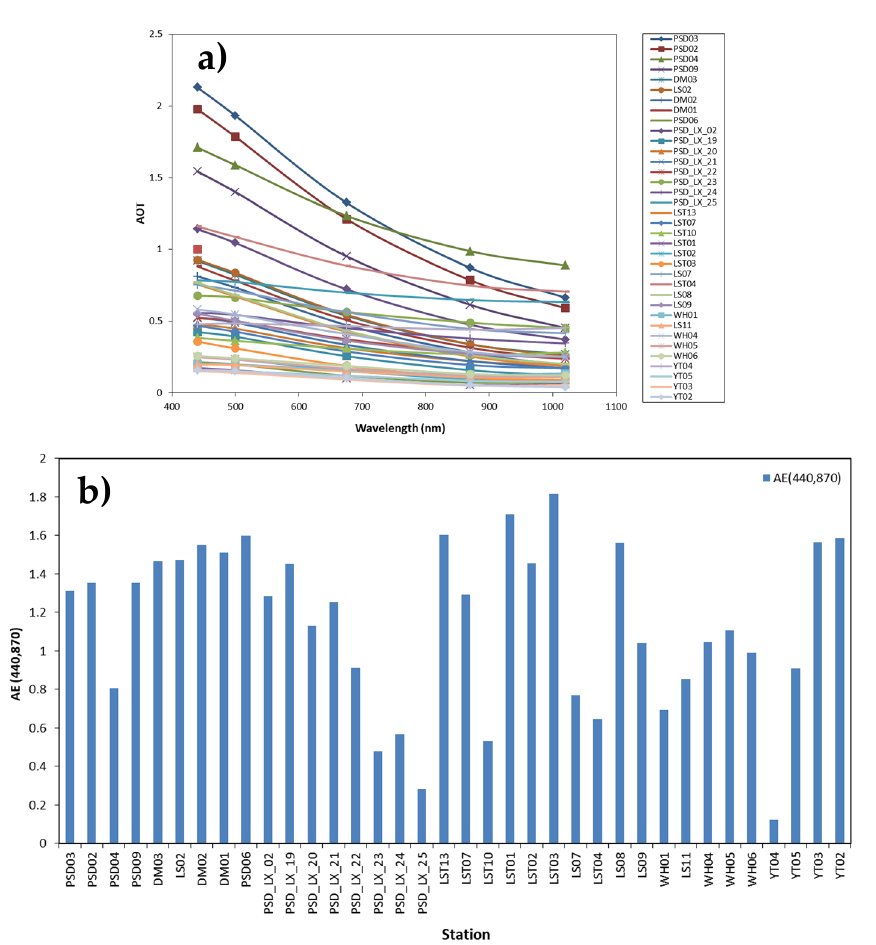
Figure 3. ( a ) Spectra of in situ aerosol optical thickness (AOT). ( b ) Histogram of in situ Angström Exponent (AE)(440,870) at 18 daytime stations.